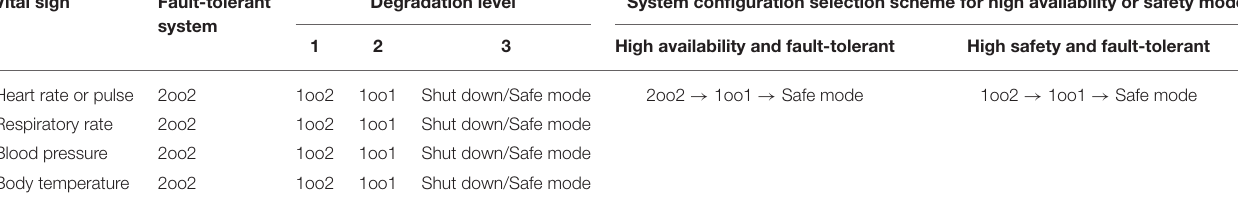
TABLE 2 | 2oo2 configured-system safe degradation scheme.